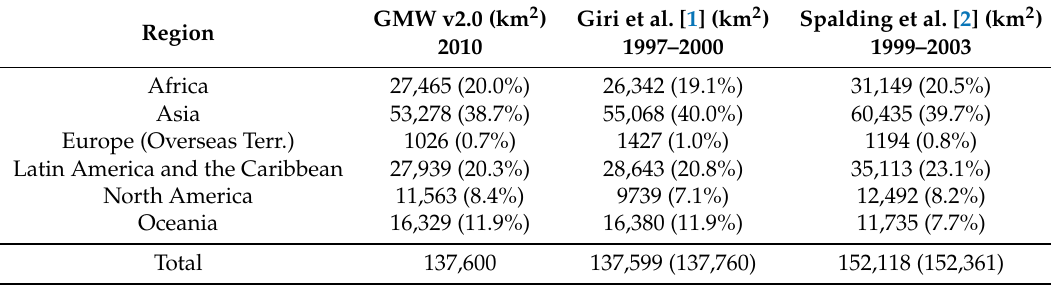
Table 6. Mangrove extent comparison for the six Ramsar regions between the GMW v2.0